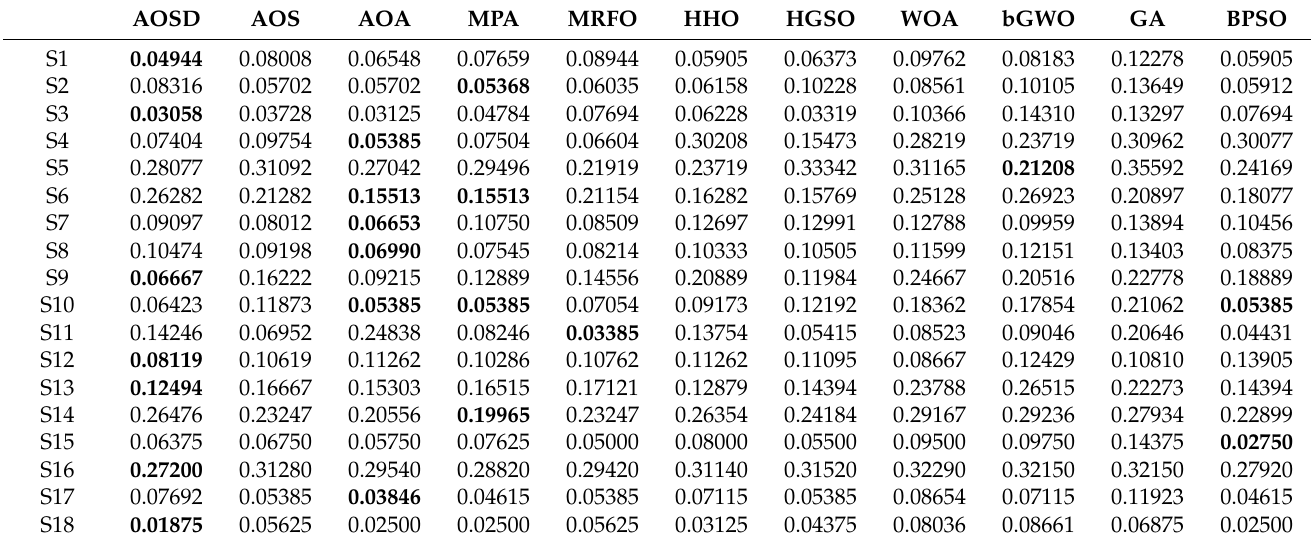
Table 6. Results of the worst fitness values’ results for FS